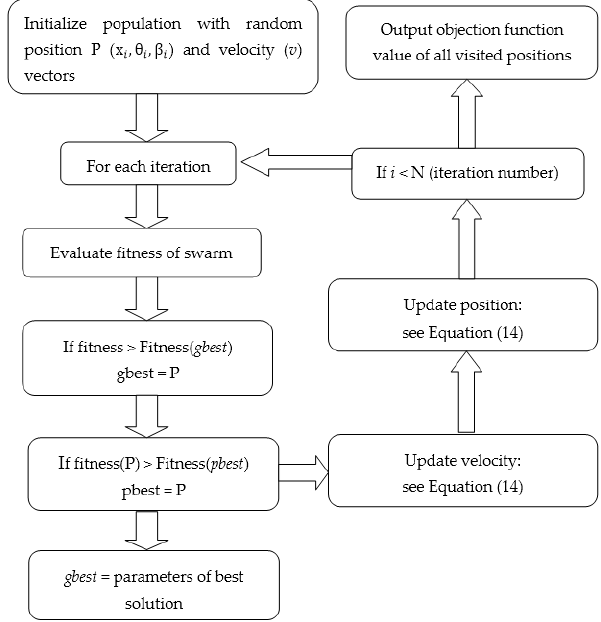
Figure 2. Flow chart depicting the multi-objective particle swarm optimization (MOPSO) algorithm.